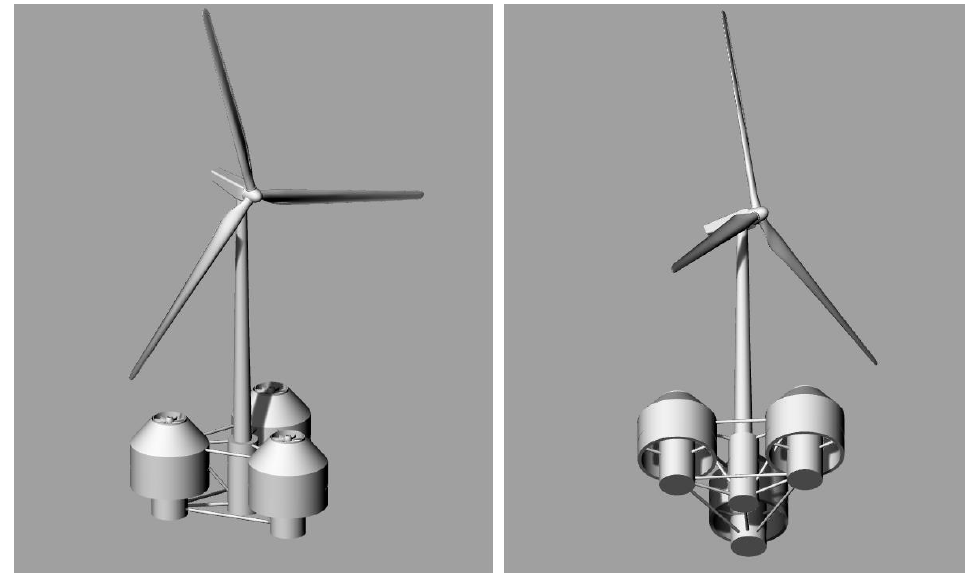
Figure 1. Renewable Energy Multi-Purpose Floating Offshore System (REFOS) structure suitable for offshore wind and wave energy exploitation: above ( left side ) and below ( right side ) sea water level (SWL).